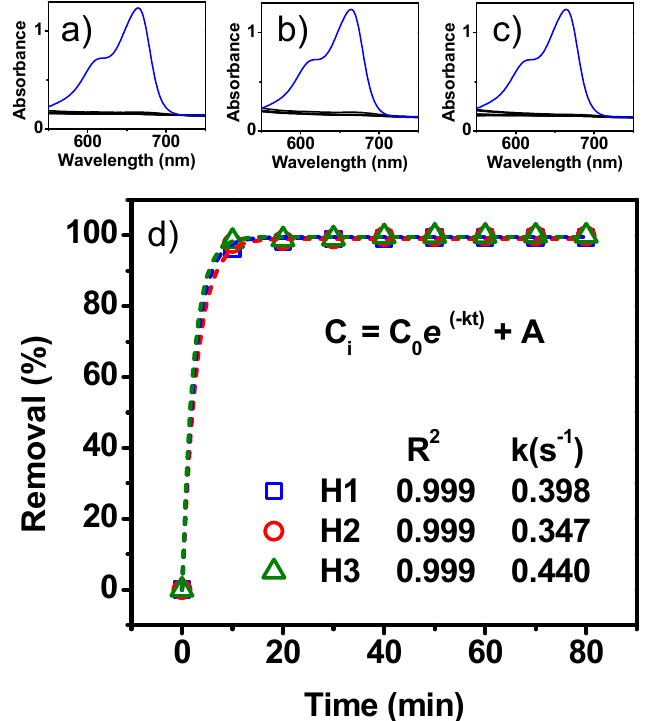
Figure 10. Evaluation of humidity percentages of the CT- Sargassum spp. in methylene blue removal: ( a , b , c ) UV-Vis spectra for H1 = 20 wt%, H2 = 30 wt% and H3 = 50 wt%, respectively. ( d ) Removal curves for each condition.